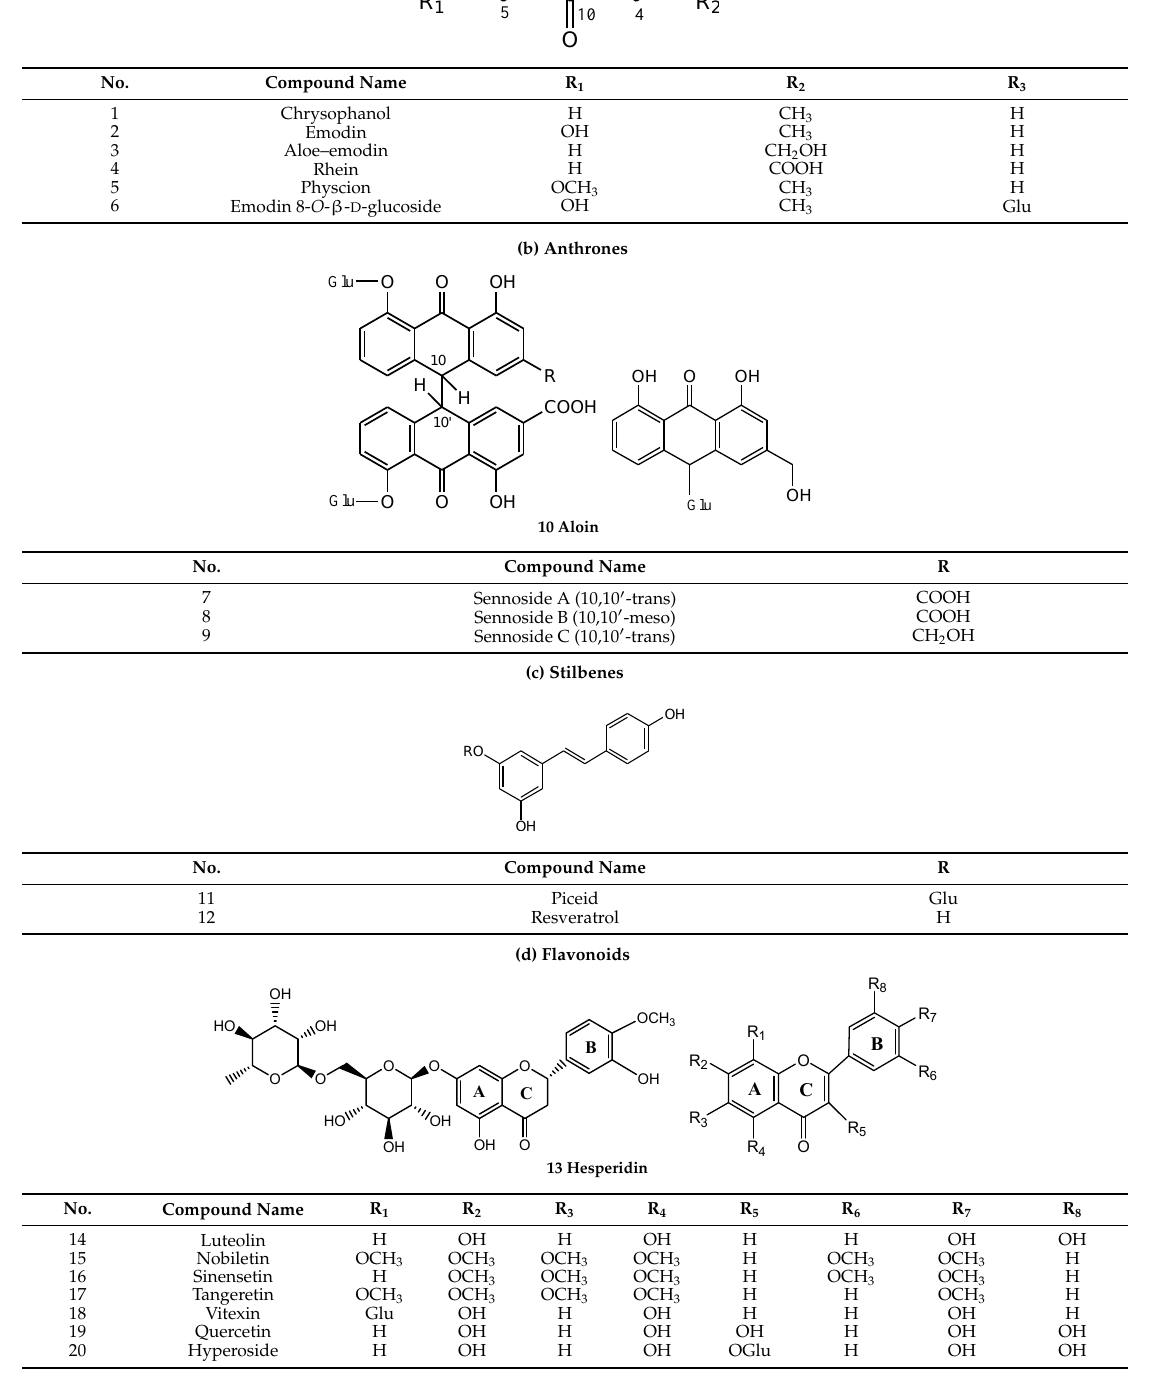
Table 2. Chemical structures of the twenty standard references.